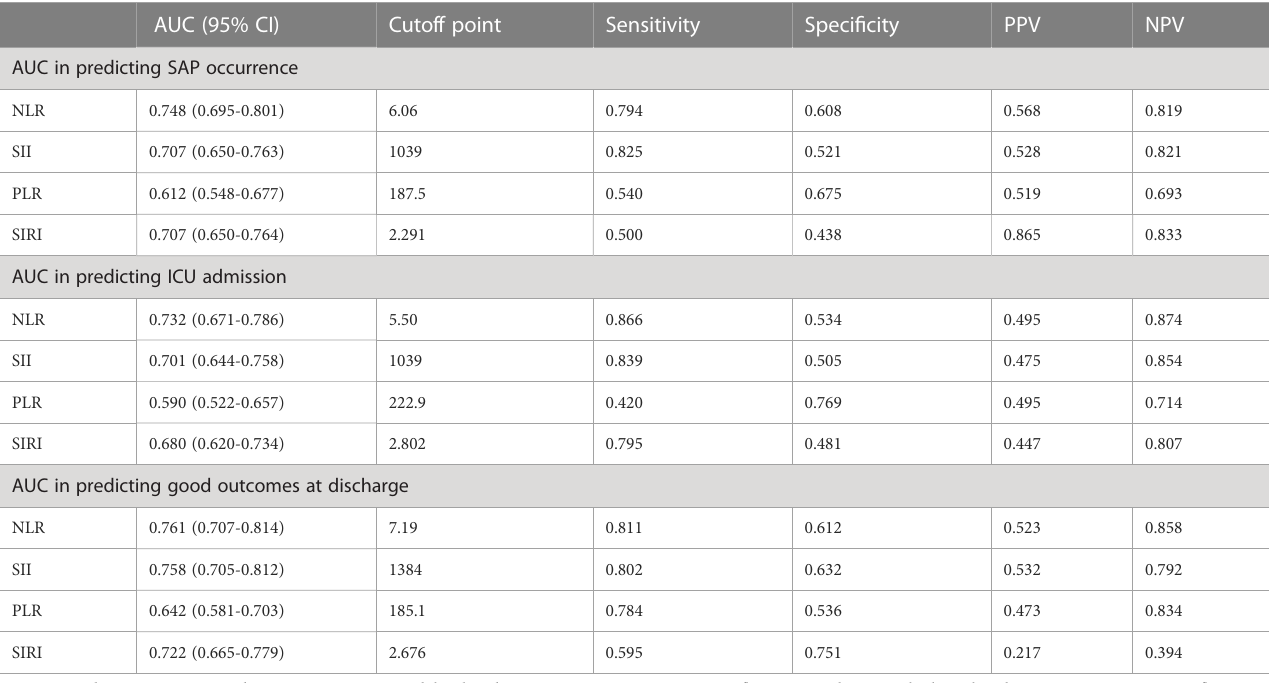
TABLE 2 AUC in predicting SAP occurrence, ICU admission and good outcomes at